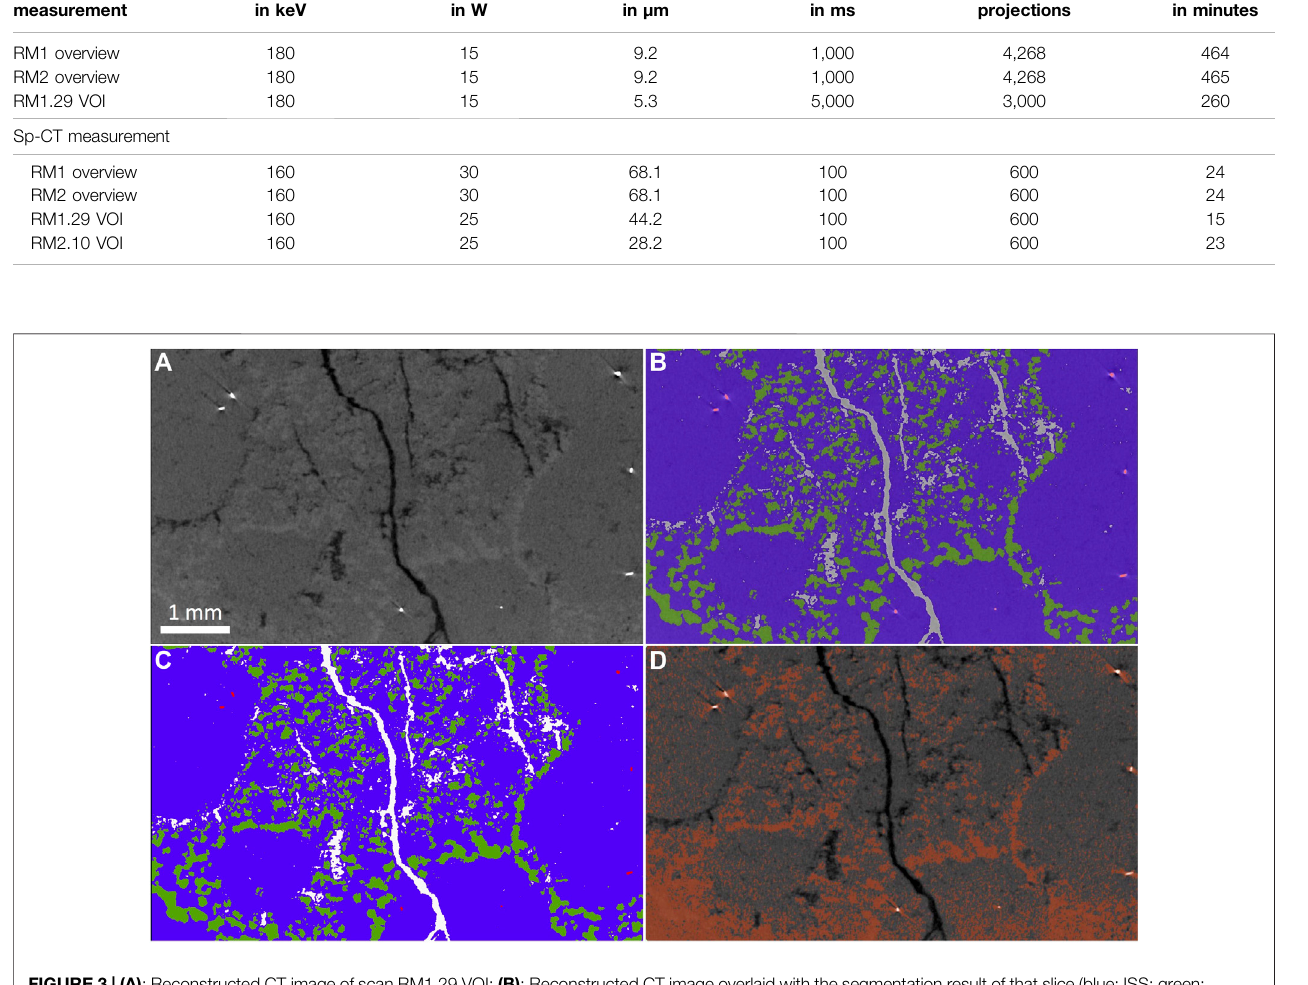
TABLE 1 | Summary of the X-ray micro-CT and sp-CT scanning conditions for the different samples. X-ray micro-CT measurement